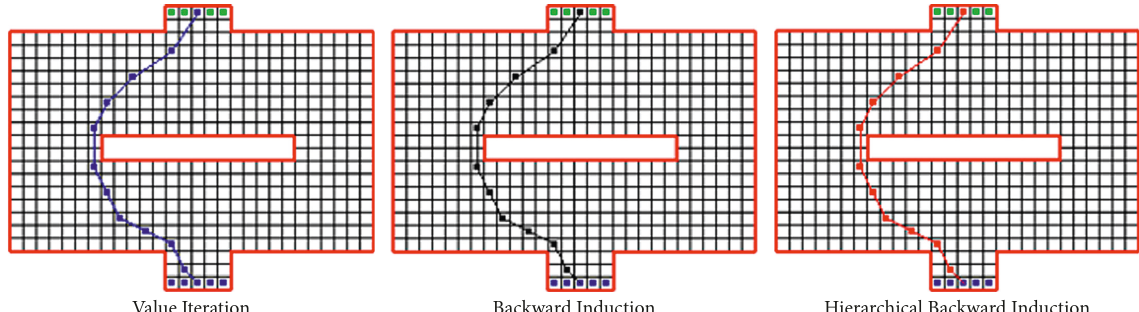
Figure 4: Road generated by VI, BI, and HBI algorithms for the racetrack-2.